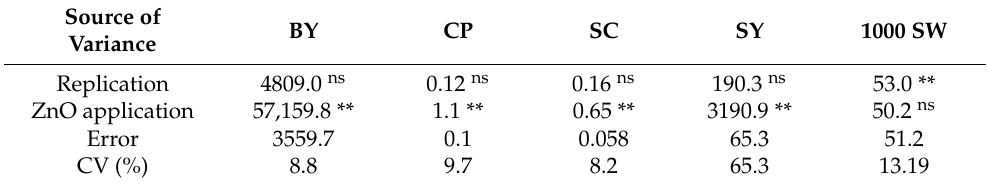
Table 4. ANOVA (mean squares) for measured traits influenced by foliar application of ZnO (first year). Source of